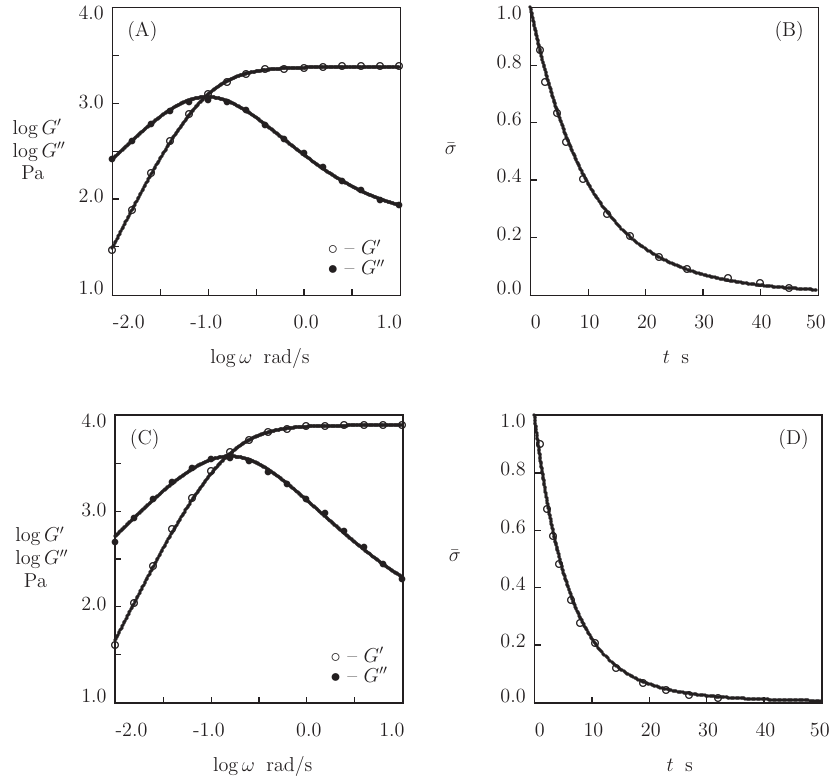
Figure 2. ( A , C )–Storage modulus G (cid:48) and loss modulus G (cid:48)(cid:48) versus frequency ω . ( B , D )–Normalized stress ¯ σ = σ ( t ) / σ ( 0 ) versus relaxation time t . Symbols: experimental data [68] on four-arm PEG gels that were cross-linked by benzaldehyde-thiol complexation of PEG-BCA and PEG–thiol chains ( A , B ) and PEG-CBCA and PEG-thiol chains ( C , D ). Solid lines: the results of simulation ( A , C ) and predictions of the model ( B , D ).